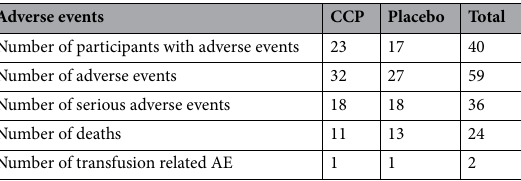
Table 4. Number of adverse events in 103 participants with severe COVID-19 randomized to treatment with convalescent plasma versus